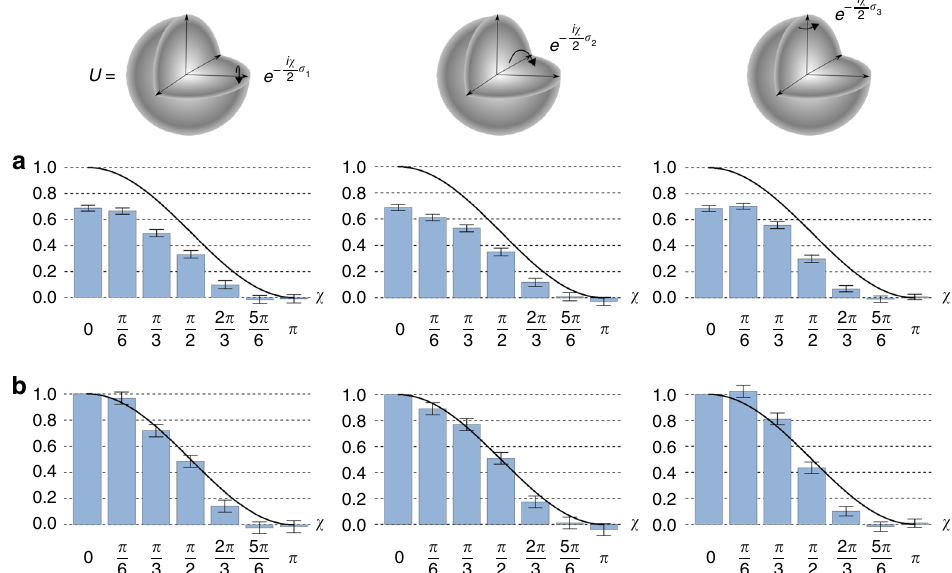
Fig. 4 Experimental results. Benchmarking results for modular DQC1 with 19 different server supplied unitary operations U k ; χ ¼ exp ð(cid:3) i χσ k = 2 Þ , where χ ranges over f 0 ; π = 6 ; π = 3 ; π = 2 ; 2 π = 3 ; 5 π = 6 ; π g and σ k ¼ σ 1 ; σ 2 ; σ 3 ranges over all three standard Pauli directions. a displays resulting experimental estimations of T ð U k ; χ Þ (blue bars), as compared to theoretic predictions (black lines). The disparity is due to decoherence. b Calibrating to account for this decoherence enables agreement between theory and experiment. Error bars in both a and b means a con fi dential interval with 95% con fi